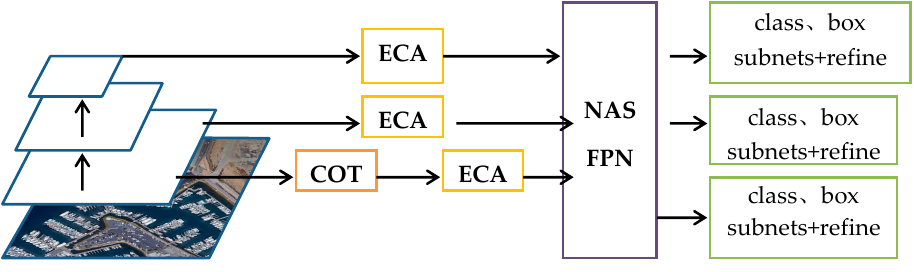
Figure 7. Structure of improved R 3 Det model.